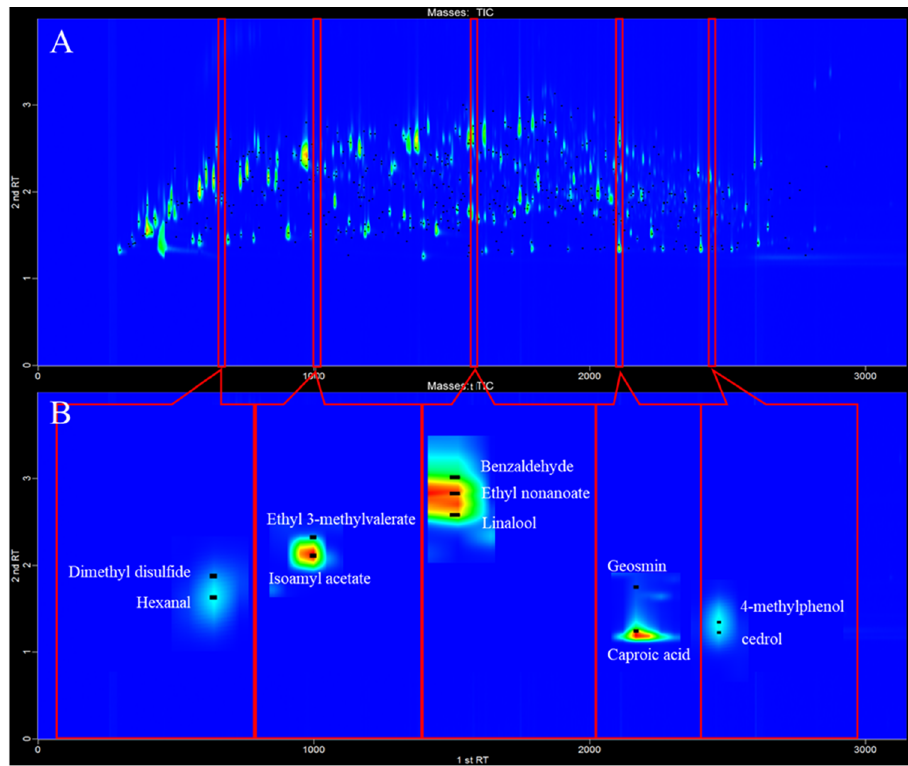
Figure 2. Analytical ion chromatogram contour plot for the SPME–GC×GC–TOFMS analysis of the Guotai sample: ( A ) complete two-dimensional contour plot and ( B ) detailed portions of the contour plot.